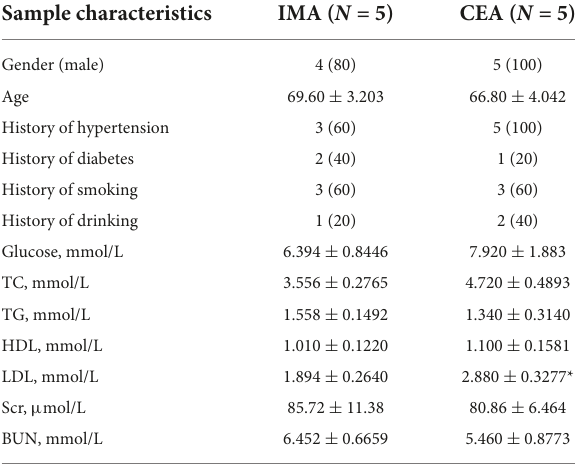
TABLE 1 Clinical characteristics of the